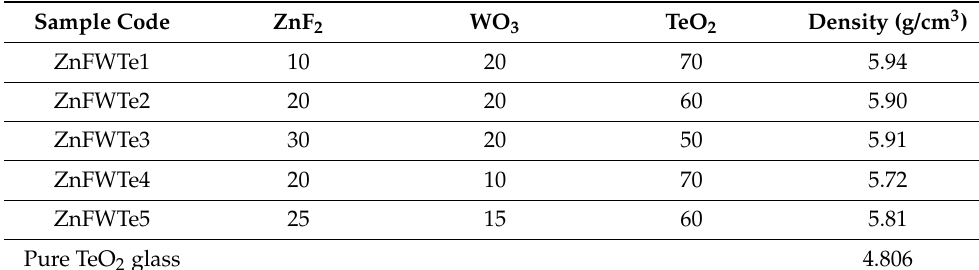
Table 1. Composition of the chosen ZnF 2 –WO 3 –TeO 2 glass system. Sample